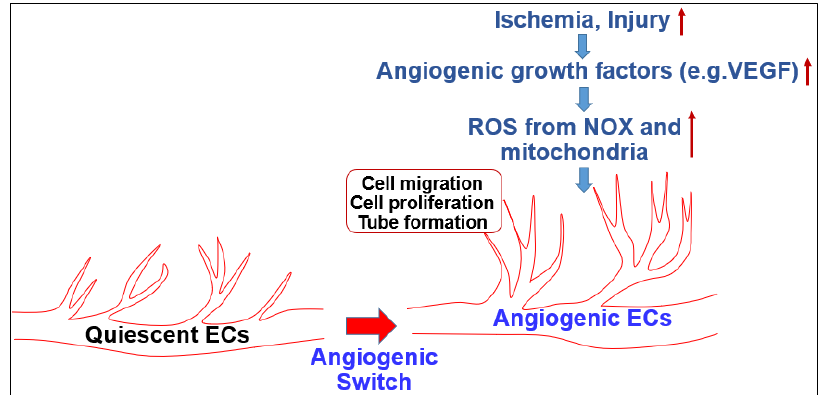
Figure 1. Role of reactive oxygen species (ROS) in angiogenesis in endothelial cells (ECs).